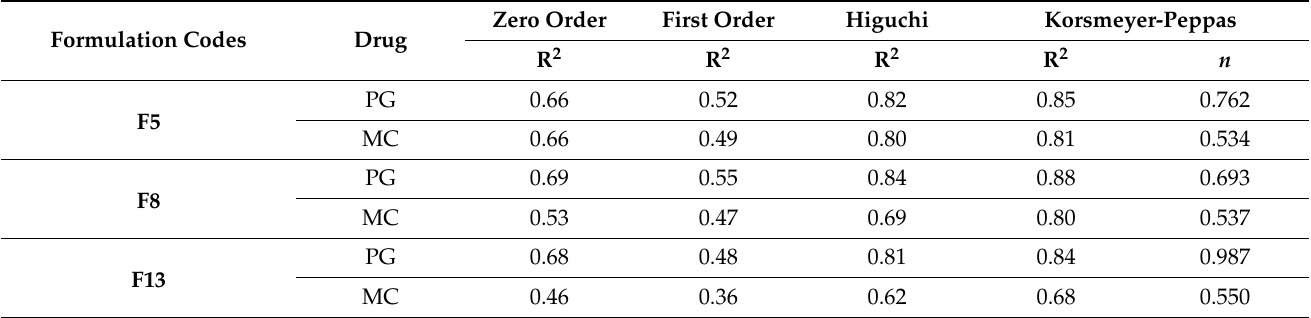
Table 8. Results of release kinetics of